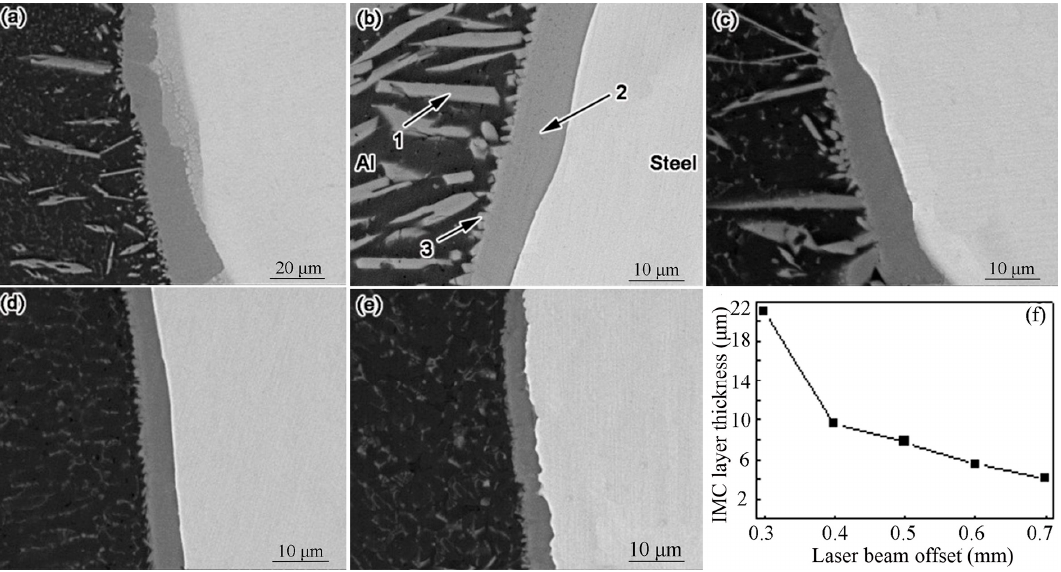
Figure 11. IMC layer microstructures at the interface of the Al/steel butt joints with different laser beam offsets: ( a ) 0.3 mm; ( b ) 0.4 mm; ( c ) 0.5 mm; ( d ) 0.6 mm; ( e ) 0.7 mm; ( f ) thickness of IMC layers.